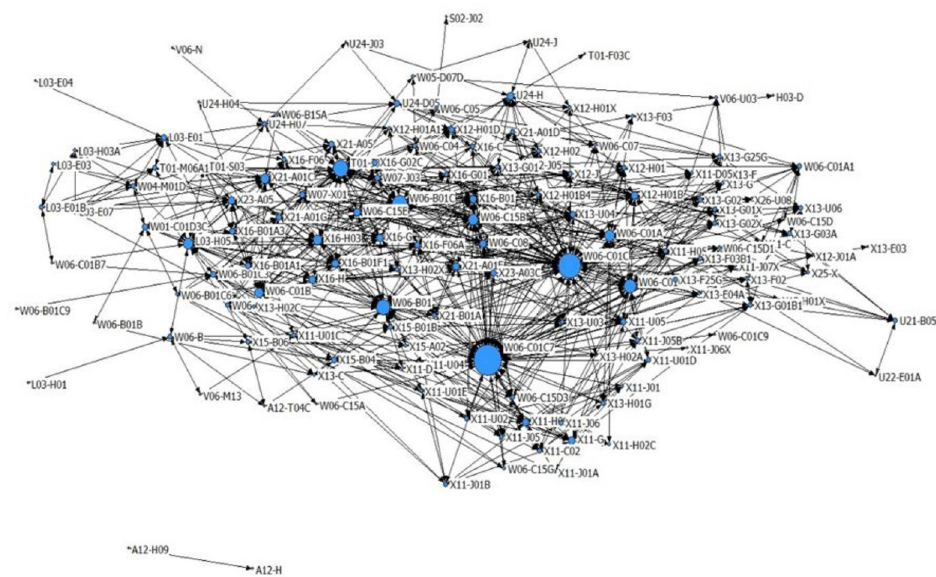
Fig 3. Cluster analysis of the MC number (strong correlation